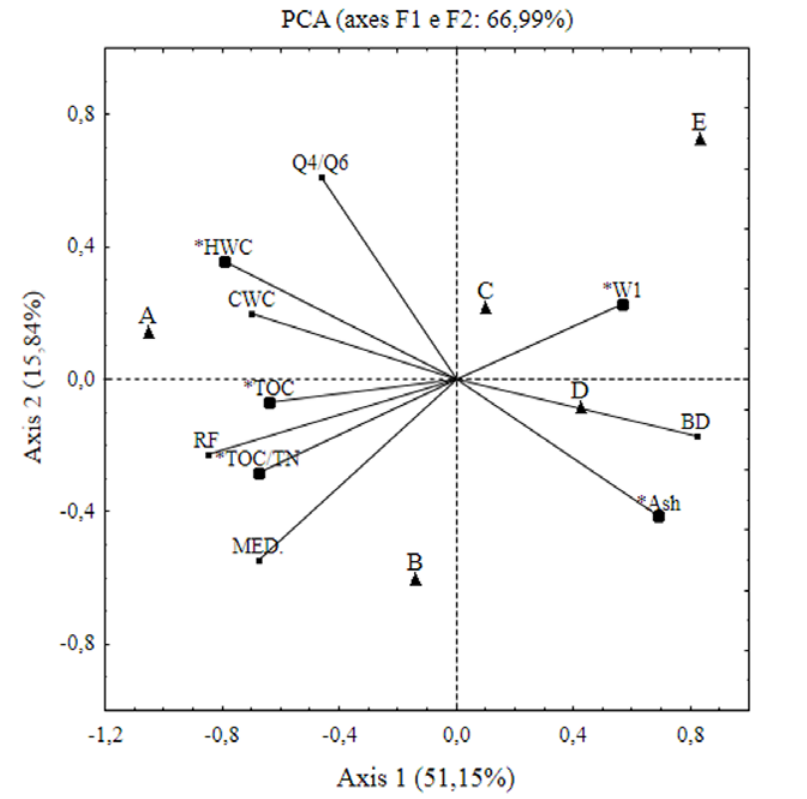
Figure 2. Principal component analysis (PCA) among soil parameters and study sites. Explanations of symbols as in Tables 3 and